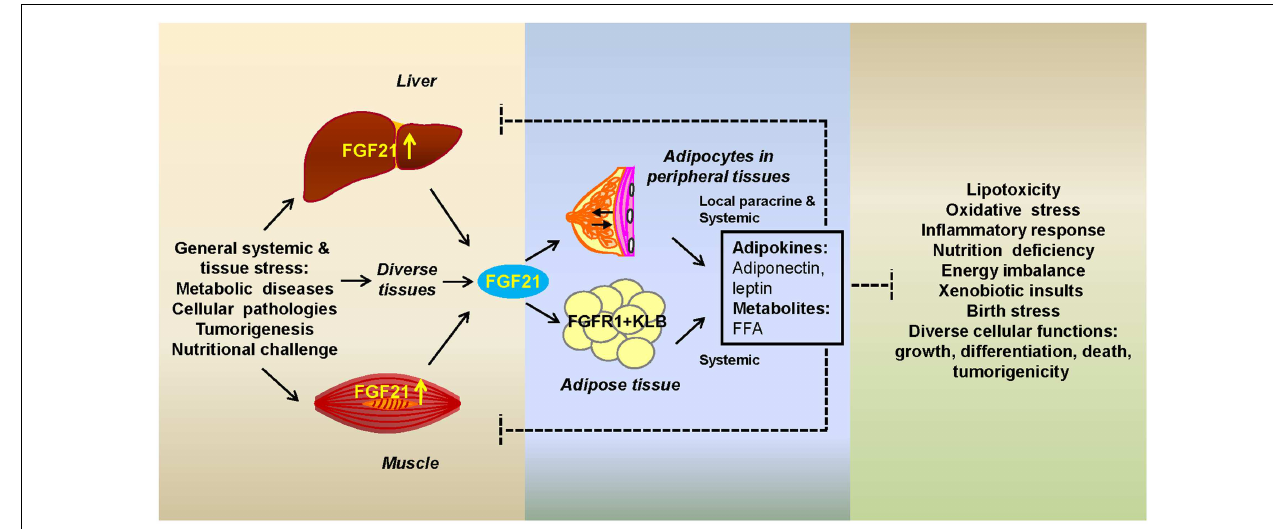
result of systemic or internal cellular stress (left box). Systemic FGF21 acts on adipocytes in major adipose depots or in the microenvironment of peripheral tissues. Breast is shown as an example of the latter. FGF21-induced adipocyte secretory products, such as adiponectin, leptin, and free fatty acids (FFAs), act both systemically or in the local microenvironment (center box) to affect stressed organs or parenchymal cells,